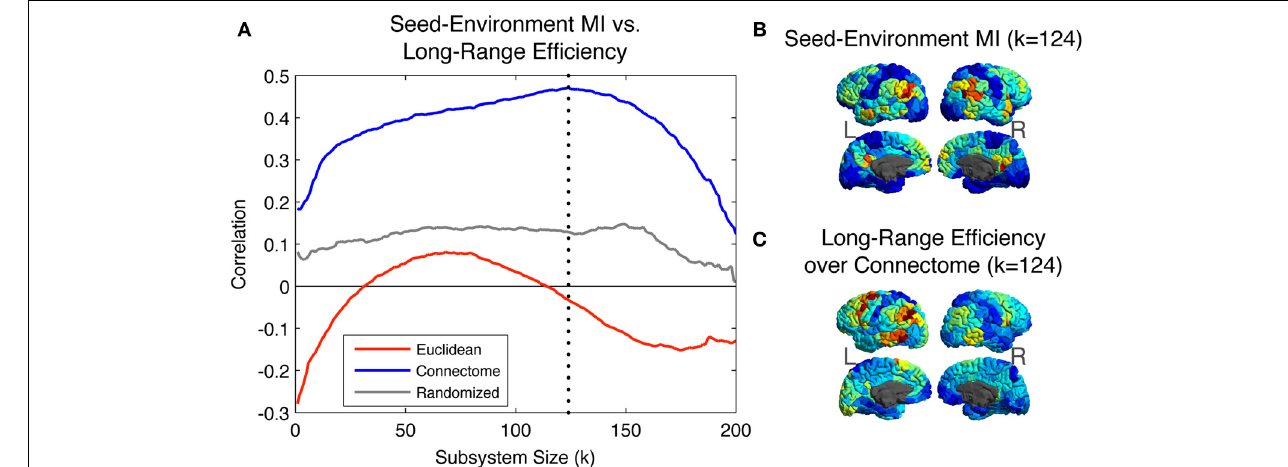
FIGURE 5 | (A) Pearson Correlation coefficient values between Seed-Environment MIs and the long-range efficiency to environmental ROIs as increasingly distant Euclidean environments are considered. Efficiency values are computed using distances defined on the three metrics. The vertical dotted line indicates subsystem size 124, where the maximal